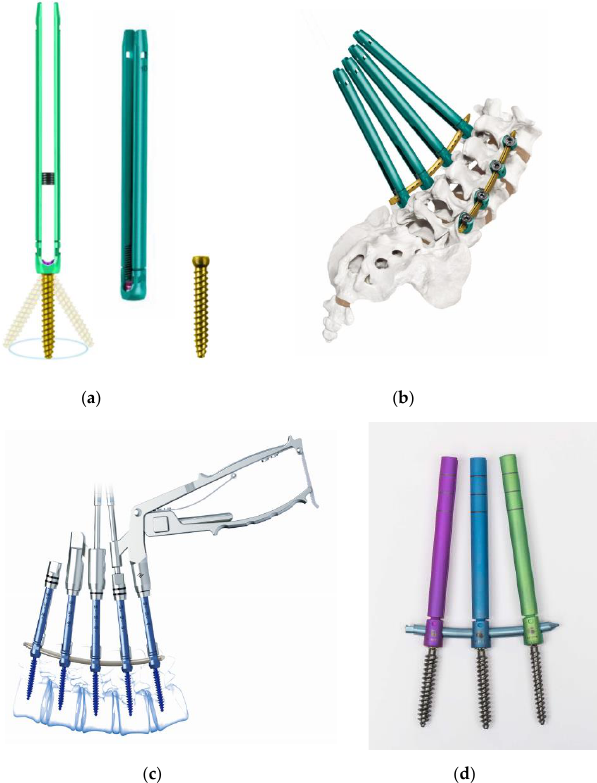
Figure 3. Third-generation PPS systems (PRECEPT ® , RELINE ® , Associa Harp ® , and Associa Zique ® ). PRECEPT ® (extender type) ( a ), PRECEPT ® (tab type) ( b ), RELINE ® (extender type) ( c ) , RELINE ® (tab type) ( d ), Associa Harp ® ( e ), and Associa Zique ® ( f ).